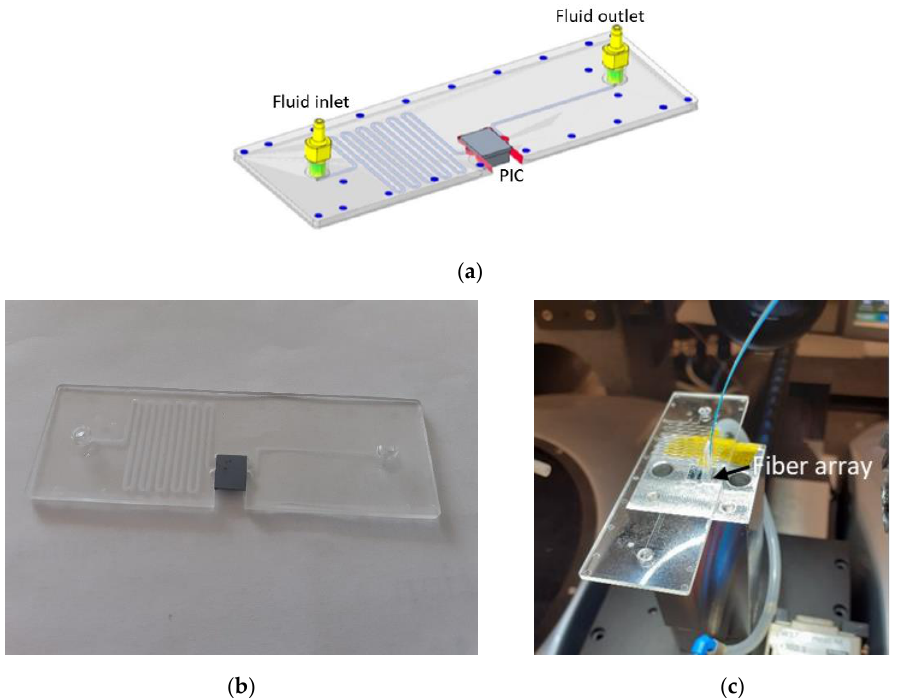
Figure 2. ( a ) 3D sketch of the microfluidic system together with the input and output fluidic ports, and the PIC assembled. ( b ) Bottom view of the silicon-based PIC assembled into the microfluidic system. ( c ) Representative picture of the optofluidic system; for the sake of clarity the required tubing to connect the microfluidic channel with the pump and the analyte container to handle the fluidics was not connected.